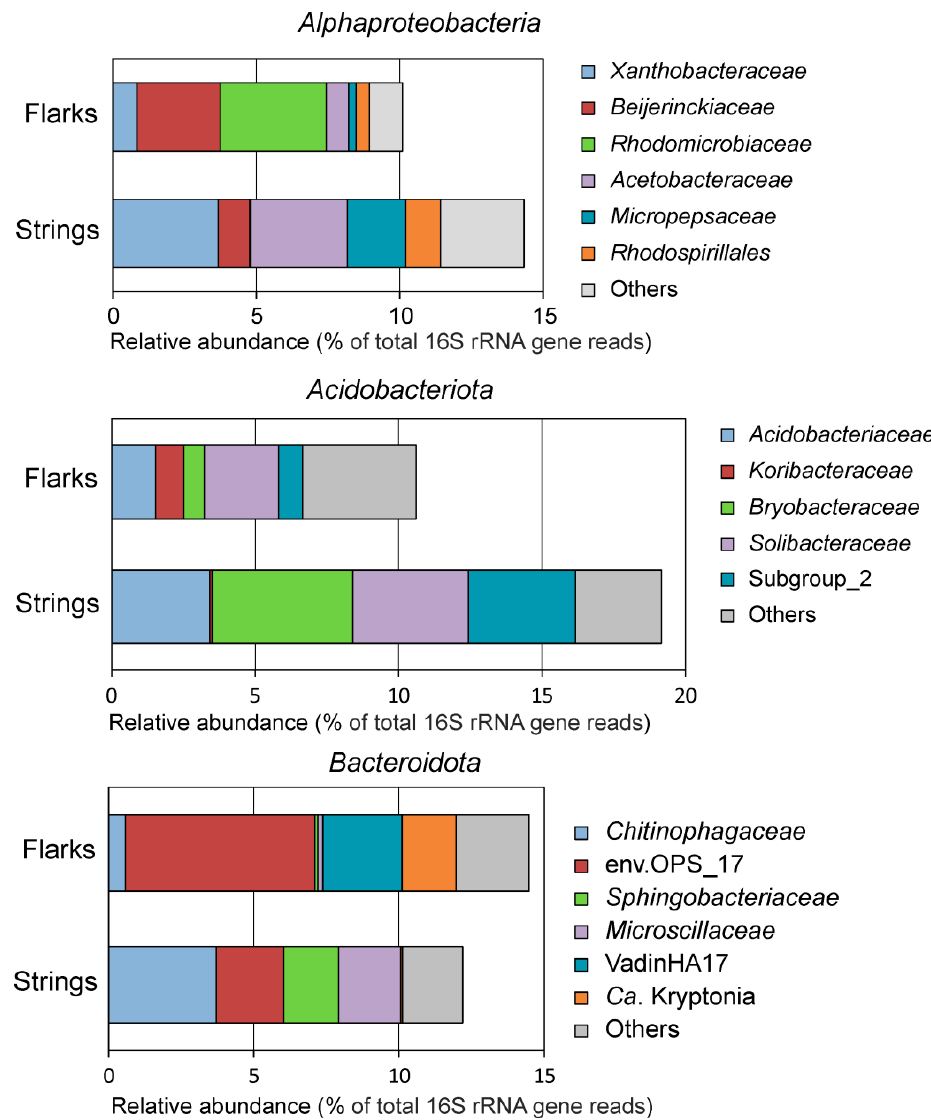
Figure 4. Composition of Alphaproteobacteria , Acidobacteriota, and Bacteroidota at family level. Mean values of relative abundances in strings and flarks are